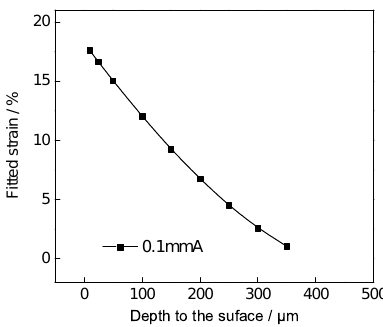
Figure 9. Fitted strain changes with depth for 0.1 mmA shot-peened IN718 specimens.